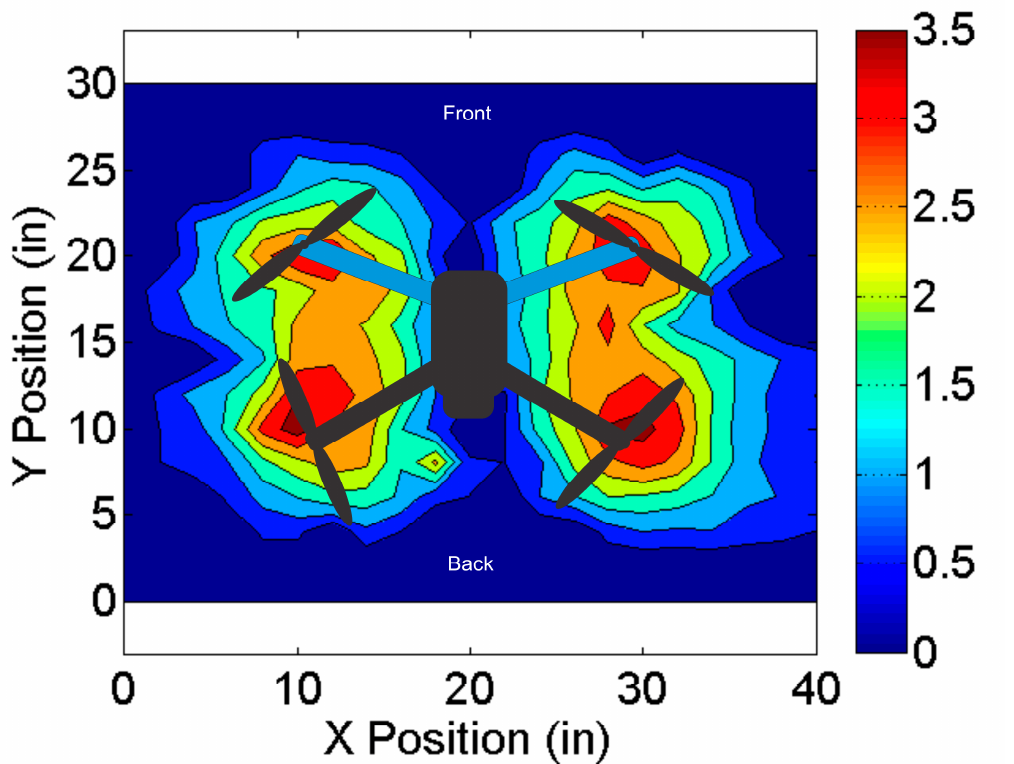
Figure A1. Propwash speed measurements (color, m s − 1 ) made using Kaindl electronic Windtronic 2 wind sensor in a plane 1 inch above the quadrotor. A 40 × 30 inch grid was created to map the data observation points of the wind speed above the quadrotor. Data points were taken every 2 inches for a total of 16 data points along the y axis and 21 data points along the x